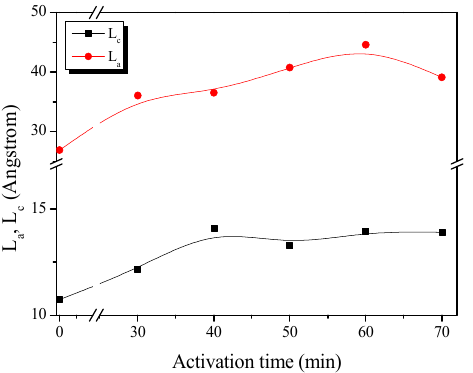
Figure 2. Structural characteristics of RACF as a function of various steam activation conditions.